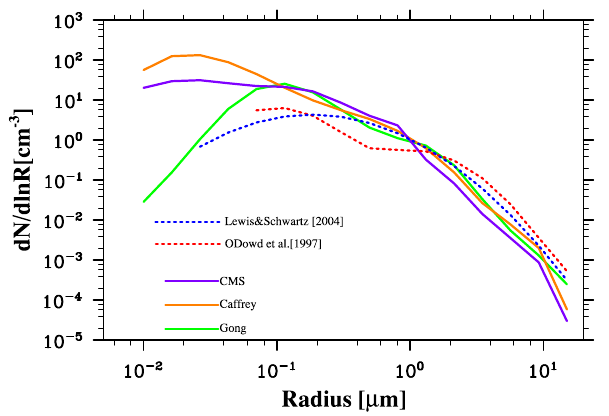
Fig. 16. Percentage of number concentration with dry radius larger than the value indicated in the model bottom layer compared be- tween model results using Gong, Caffrey and CMS source func- tion and Clarke et al. (2006). The model size distributions are from the grid cell containing the Midway Island in June 2006.The model used a solubility factor of 0.5.